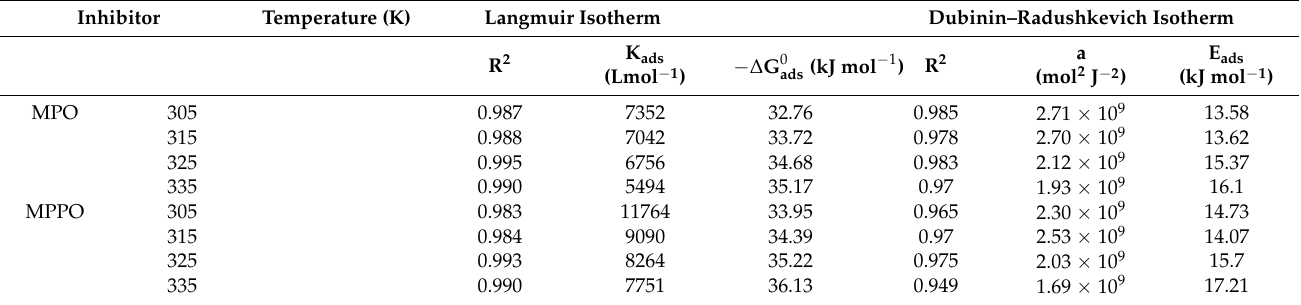
Table 5. Thermodynamic parameters for adsorption of inhibitors in 1.0 M HCl on N80 steel surface at different